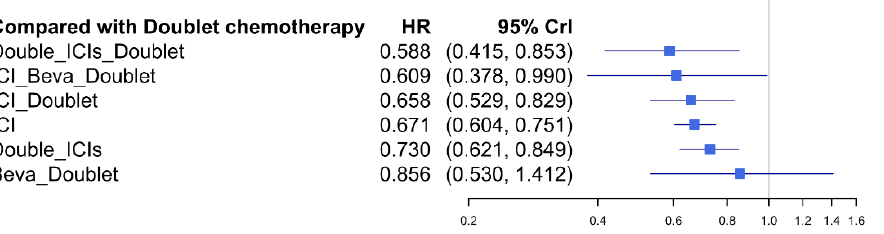
Figure 4. Network forest plot of each treatment strategy compared with doublet chemotherapy for OS.